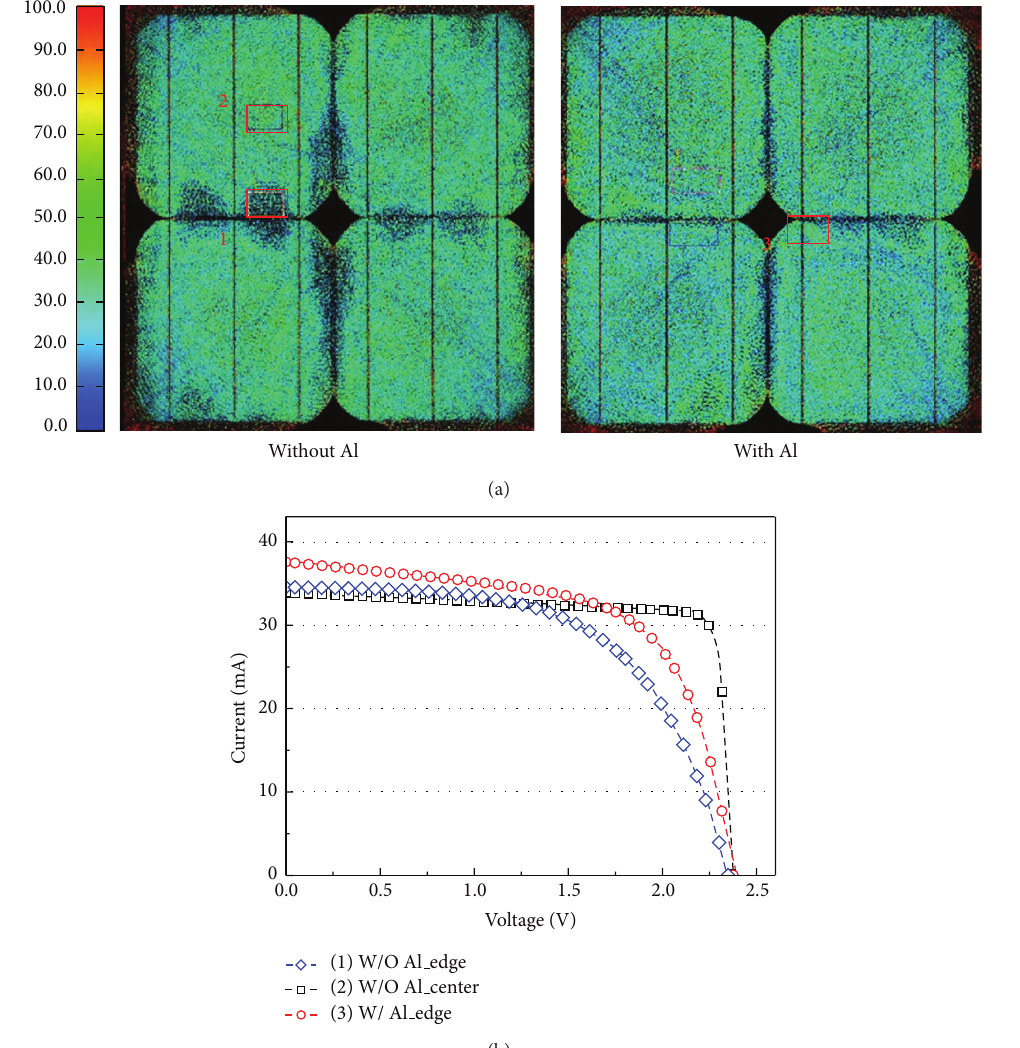
Figure 10: I-V mapping analysis of PV modules: (a) 𝑅 𝑆 mapping images without and with Al sacrificial anodes (SA) and (b) I-V curves of each marked position in the cell after 2500 h of DH